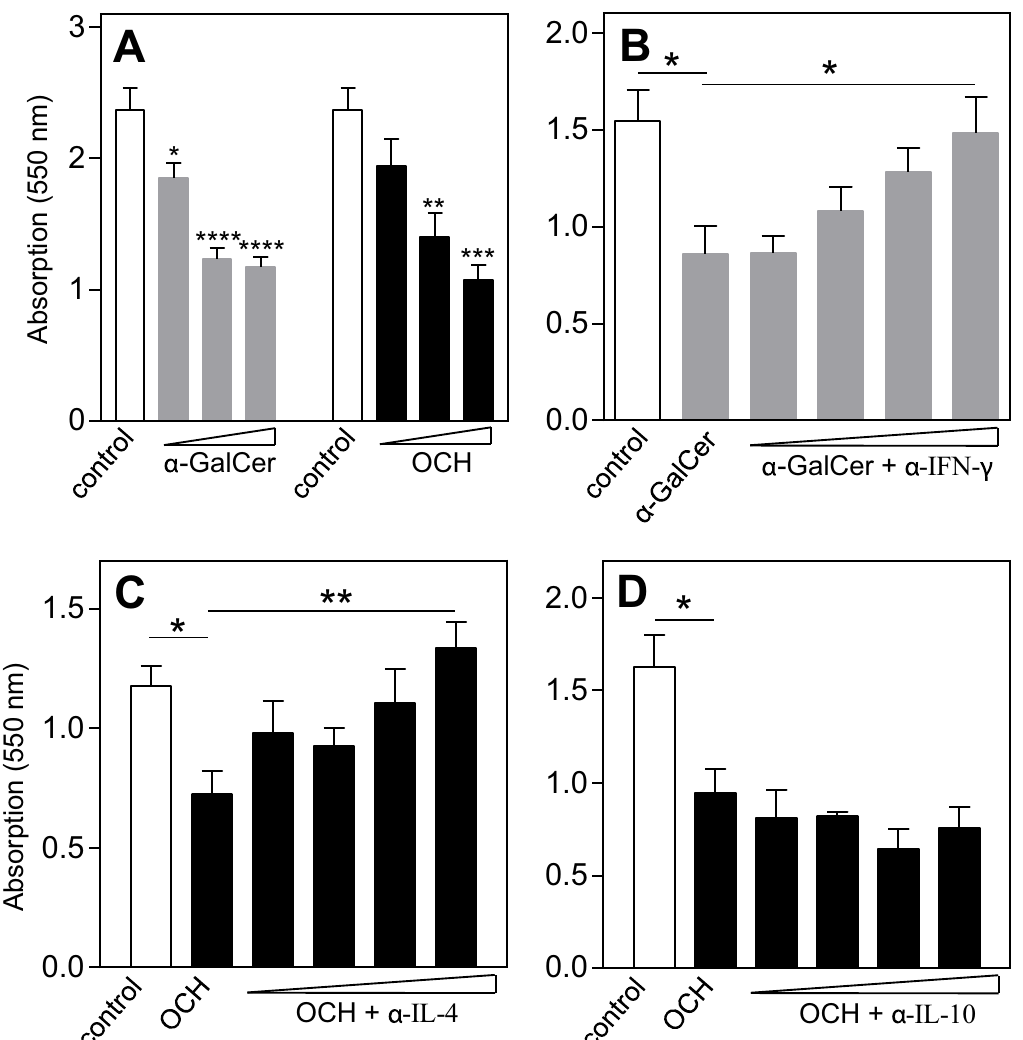
Fig 5. Cytokine dependent decrease in vSMC viability after type I NKT cell activation. Splenocytes were cultured in presence of type I NKT cell specific ligands α -GalCer or OCH (50, 100 and 200 ng/ml) for 48 hours. Subsequently, supernatant of the splenocytes was added to vSMCs for 72 hours and viability of the vSMCs was assessed by an MTT assay (A). In addition, supernatant of the α -GalCer (200 ng/ml) stimulated splenocytes was pre-incubated with α -IFN- γ antibodies (B) and supernatant of OCH (200 ng/ml) stimulated splenocytes with α - IL4 (C) and α -IL10 (D) antibodies prior to addition of the supernatant to vSMCs. All values are mean±SEM and statistical analysis was performed using one-way ANOVA. (cid:3) P < 0.05, (cid:3)(cid:3) P < 0.01, (cid:3)(cid:3)(cid:3) P < 0.001, (cid:3)(cid:3)(cid:3)(cid:3) P <